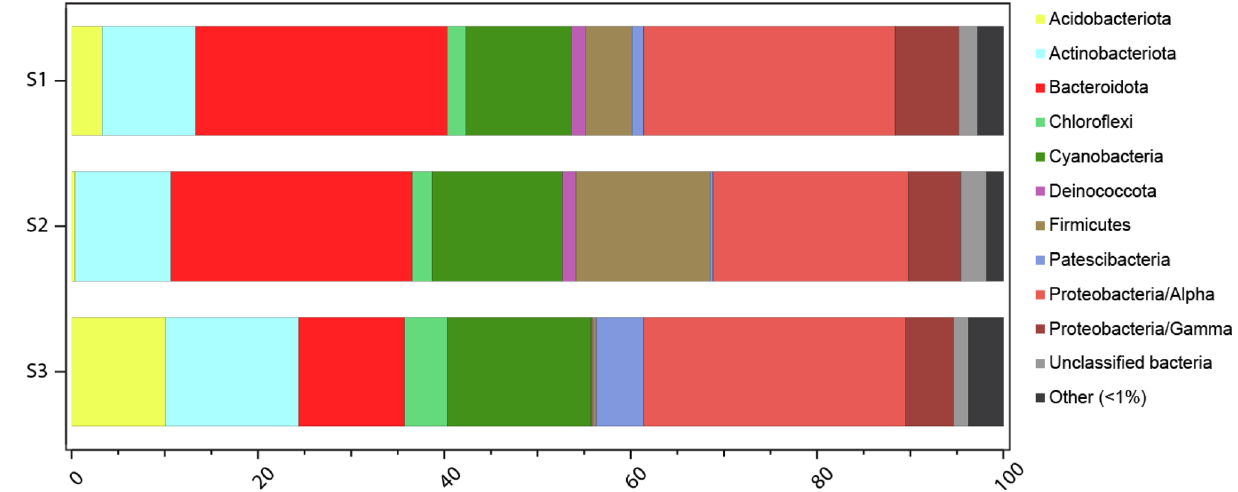
Figure 1. Systematic diversity of the crab’s carapace microbiota: Relative abundance of bacterial phyla and Proteobacteria classes obtained by 16S rRNA gene sequencing. Taxa contributing < 1% are not